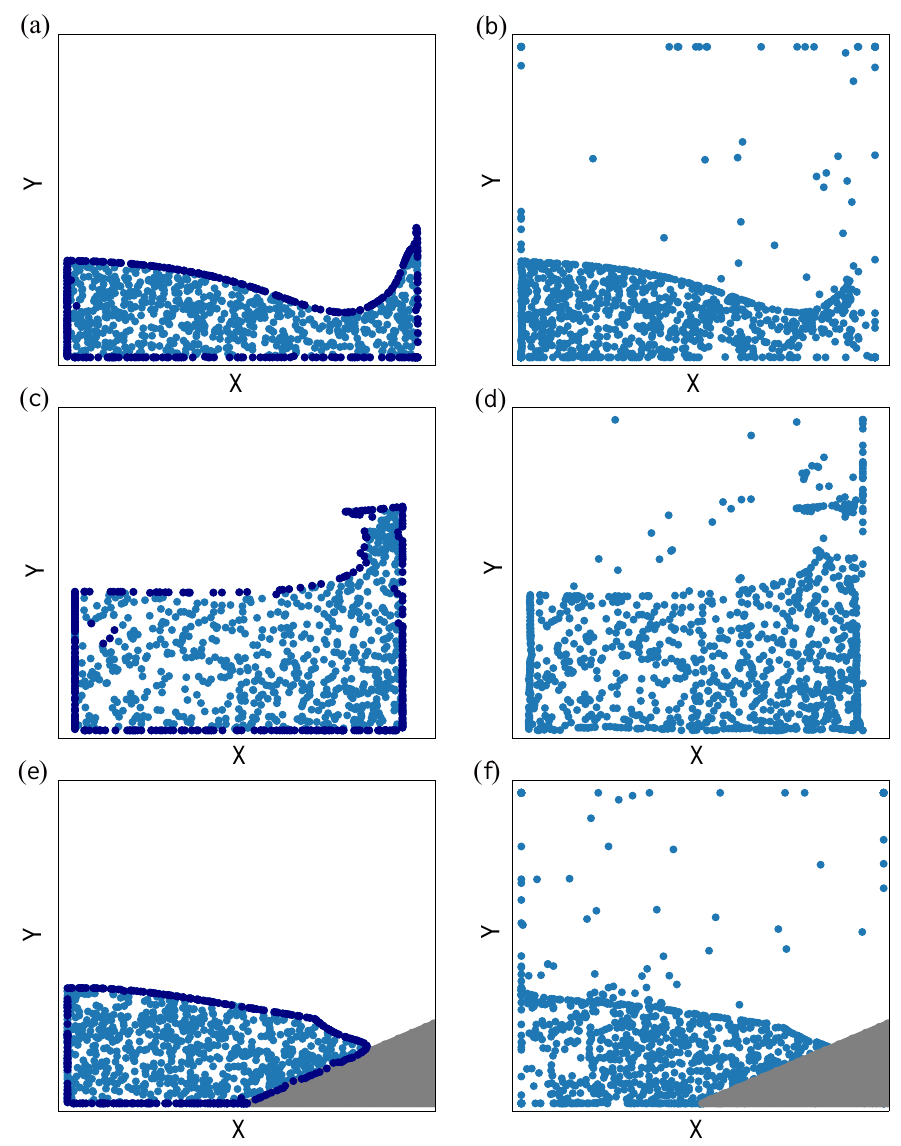
Figure 10. Comparison of results obtained by the improved NPM and SPH with the same random particle distribution in different numerical examples. ( a ) Dam break simulated by INPM, ( b ) Dam break simulated by SPH, ( c ) Violent sloshing simulated by INPM, ( d ) Violent sloshing simulated by SPH, ( e ) Slope climbing simulated by INPM, and ( f ) Slope climbing simulated by